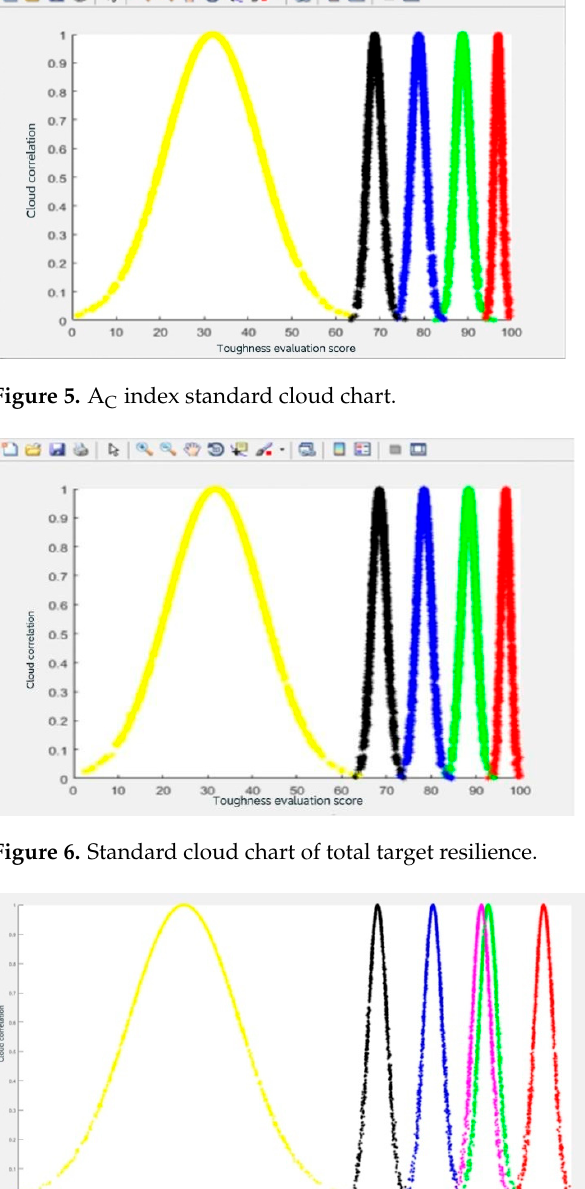
Figure 4. A C 1 index standard cloud chart.